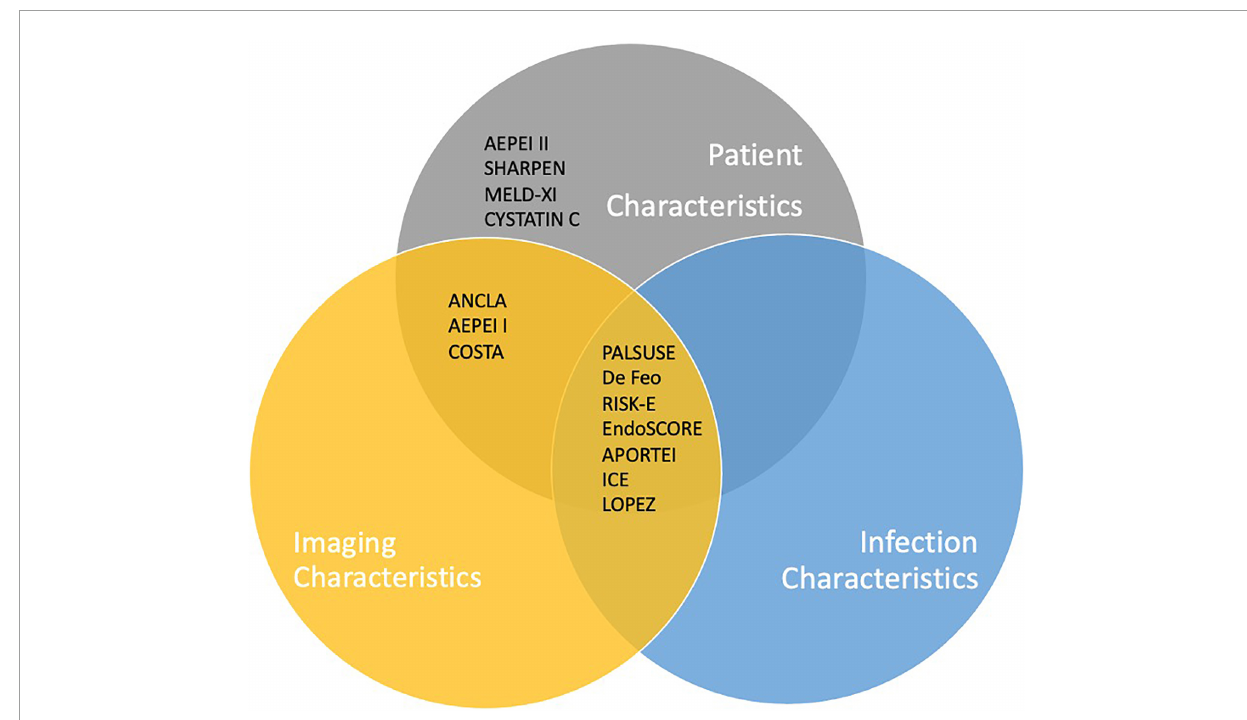
FIGURE1 Key components for an Infective Endocarditis Risk Score.